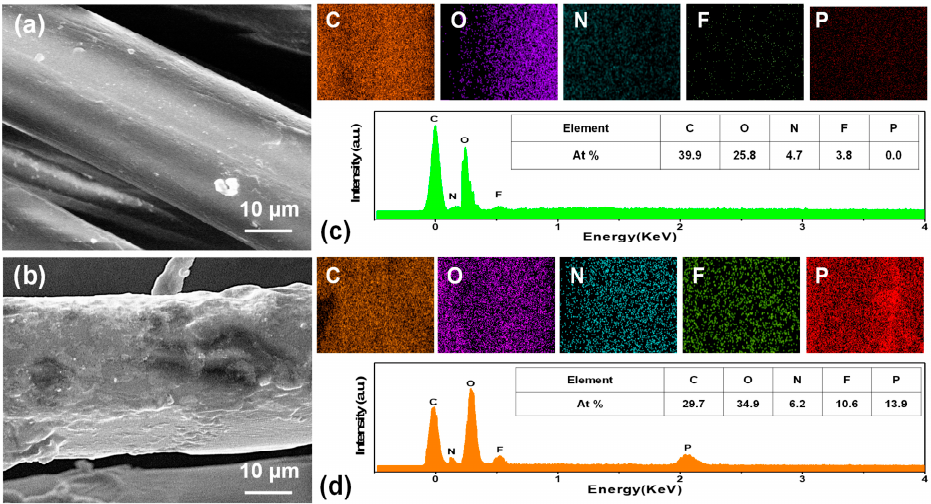
Figure 3. The SEM and EDS element mapping with their atomic ratio (At), table (inset) of aramid fabric after coating, and 10 times washing ( a , c ) for UCW 10 and ( b , d ) for PCW 10 , respectively.